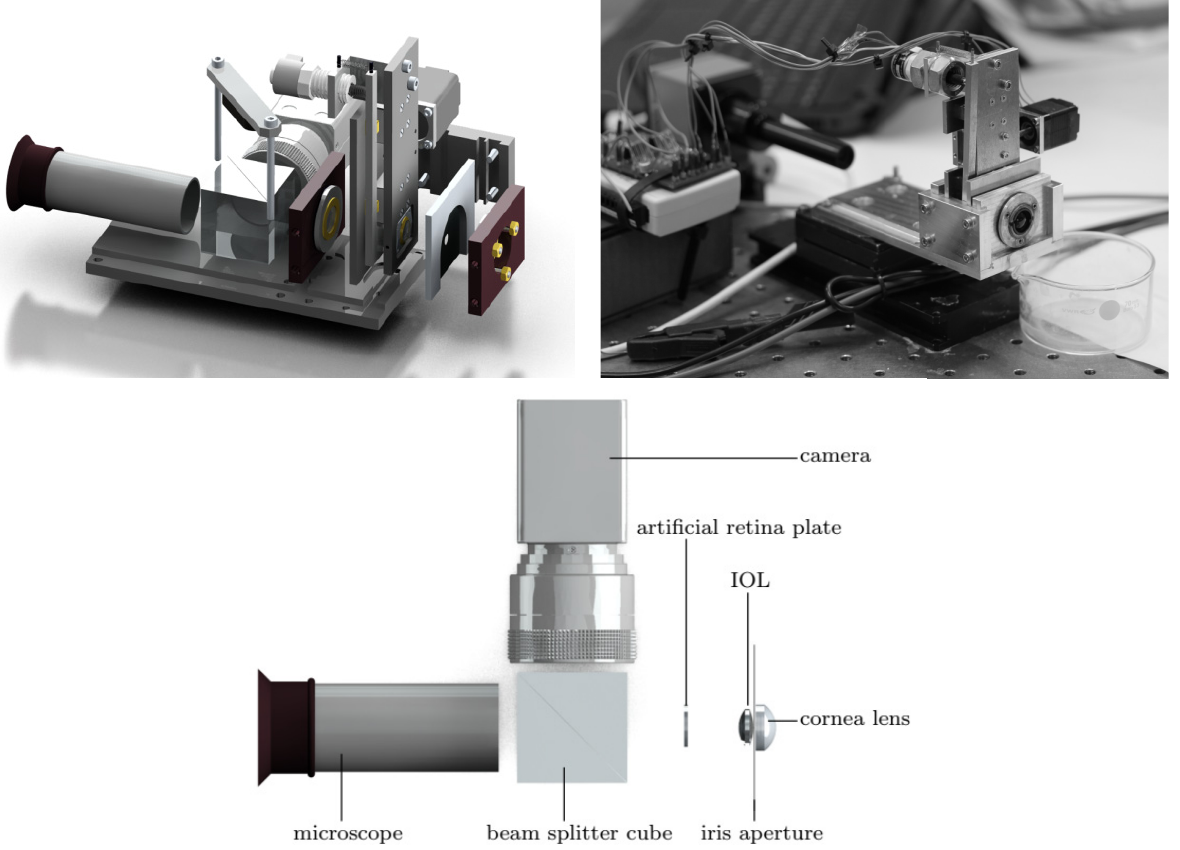
Figure 15. ( Top ) 3D rendering and real photography of the device used by Drauschke et al.; ( Bottom ) schematic painting of the measurement setup. © 2013 International Federation of Automatic Control. Reproduced with permission from Andreas Drauschke, Elisabet Rank, Lukas Traxler, Kirsten Lux, Christian Krutzler, “Mechanical Eye Model for Comparison of Optical and Physiological Imaging Properties”. IFAC Proceedings Volumes, 46/28 (2013), pp. 1–12 ([48]).